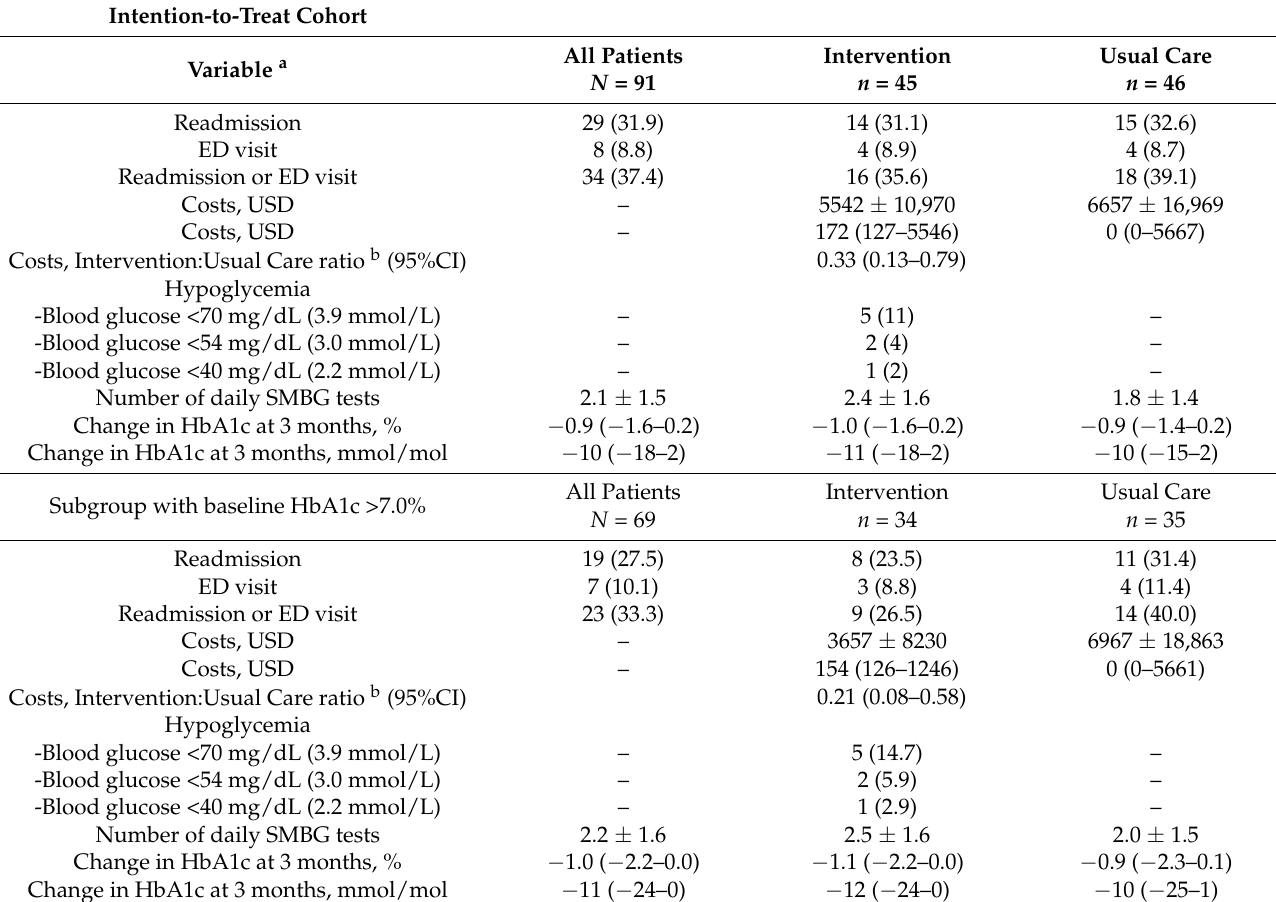
Table 2. Outcomes in Intervention and Usual care